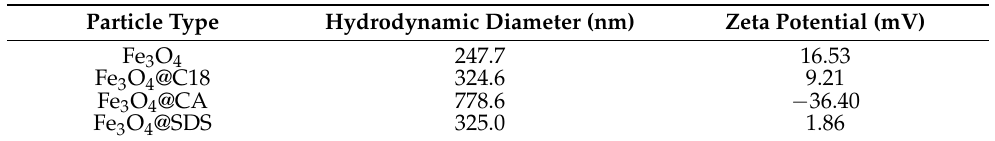
Table 1. Hydrodynamic diameter and zeta potential of synthesized iron oxide (Fe 3 O 4 ), iron oxide modified with silica gel (Fe 3 O 4 @C18), iron oxide modified with citric acid (Fe 3 O 4 @CA), and iron oxide modified with sodium dodecyl sulphate (Fe 3 O 4 @SDS)